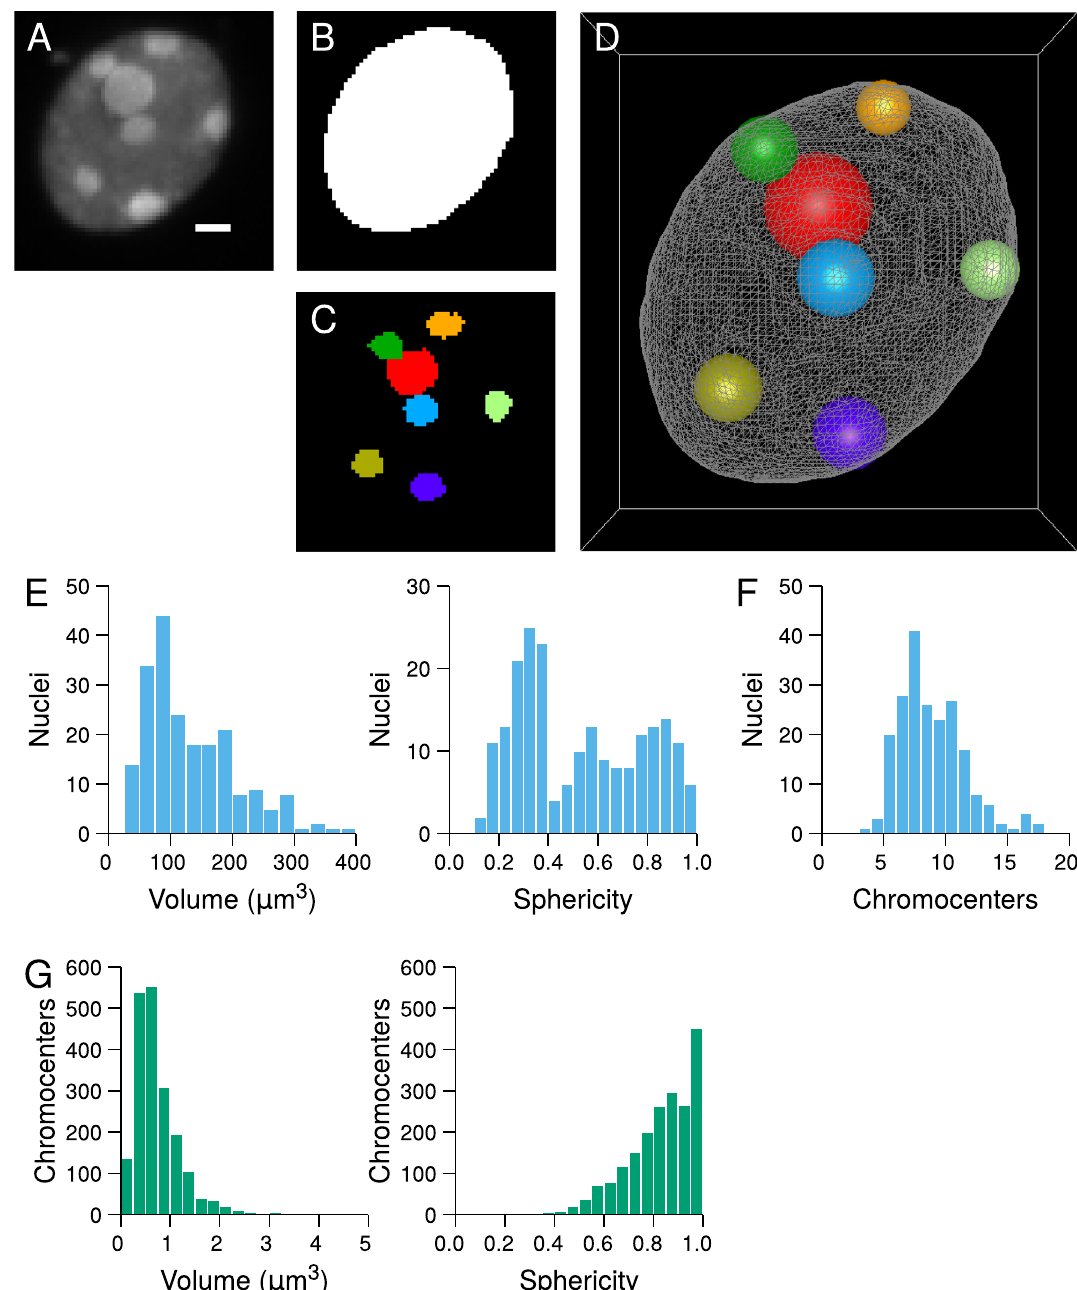
Figure 1. Generation of 3D representations in continuous space from discrete image data and quantitative image analysis of Arabidopsis thaliana plantlet nuclei. ( A ) Confocal image of an A. thaliana DAPI-stained nucleus. Chromocenters appear as bright foci. Scale bar: 1 µ m. ( B ) Segmentation mask of the nucleus. ( C ) Segmentation masks of the chromocenters. ABC show maximum intensity projections of the corresponding 3D images. ( D ) 3D reconstruction of the nucleus (triangular mesh) with chromocenters represented by their equivalent spheres. ( E ) Distribution of nuclear size and shape parameters. ( F ) Distribution of the number of chromocenters per nucleus. ( G ) Distribution of chromocenter size and shape corresponding simulations were conditioned on the observed shape of the nucleus and on the number and individual sizes of CCs in the pattern. A similarly conditioned second set of simulations were performed to estimate the expected fluctuations around the averages under the model and to compute the SDIs (see Methods). For most nuclei (as the one shown in Fig. 2A ′ ), the observed function F was shifted to the left of ˆ F rand (Fig. 2B ′ ), showing that regions devoid of CCs were on average smaller than under a random distribution. The slope of the observed function F was steeper, pointing to a more homogeneous size distribution of empty spaces between CCs. Function G was shifted to the right of ˆ G rand (Fig. 2C ′ ), corresponding to larger distances